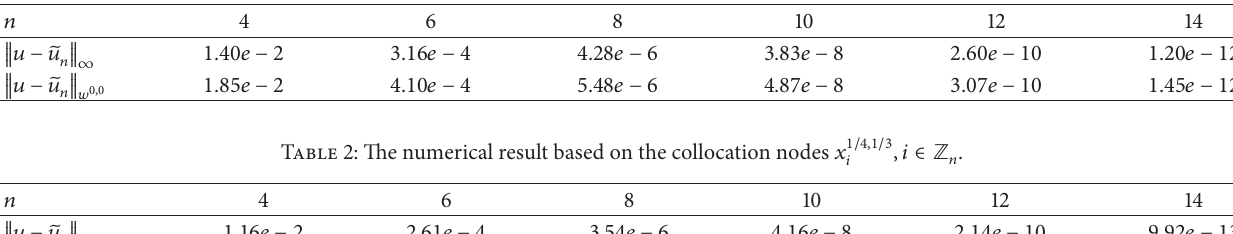
Table 1: The numerical result based on the collocation nodes 𝑥 0,0 𝑖 , 𝑖 ∈ Z 𝑛 .